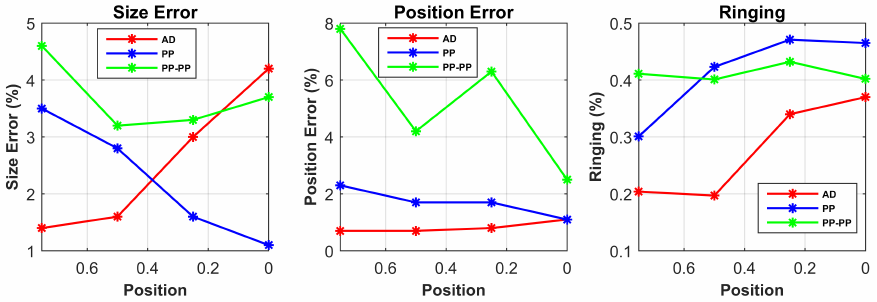
Figure 7. Performance parameters from simulated data are shown in the case of single point input positions.